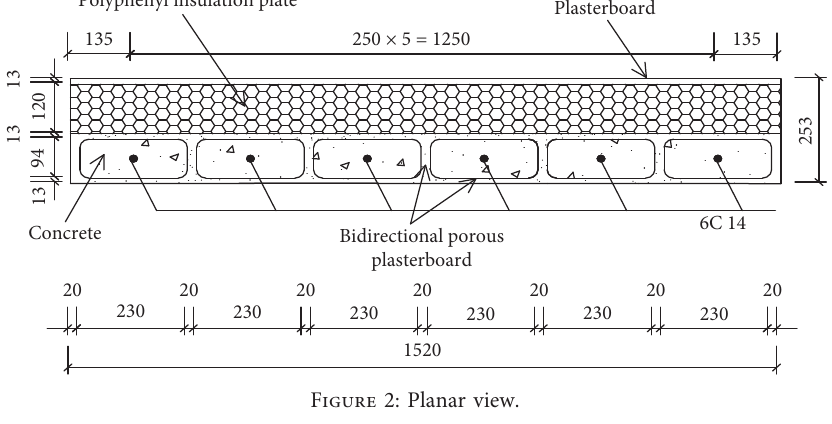
Figure 2: Planar view.